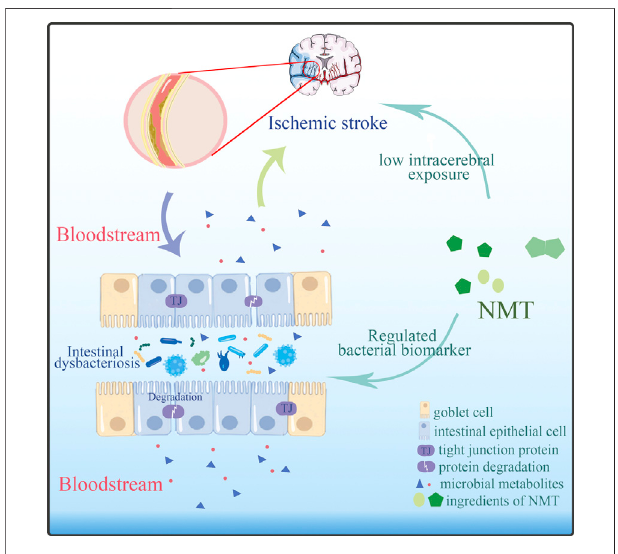
FIGURE 9 | NMT modi fi ed the outcome of stroke by adjusted the imbalanced intestinal fl ora and its metabolic pro fi